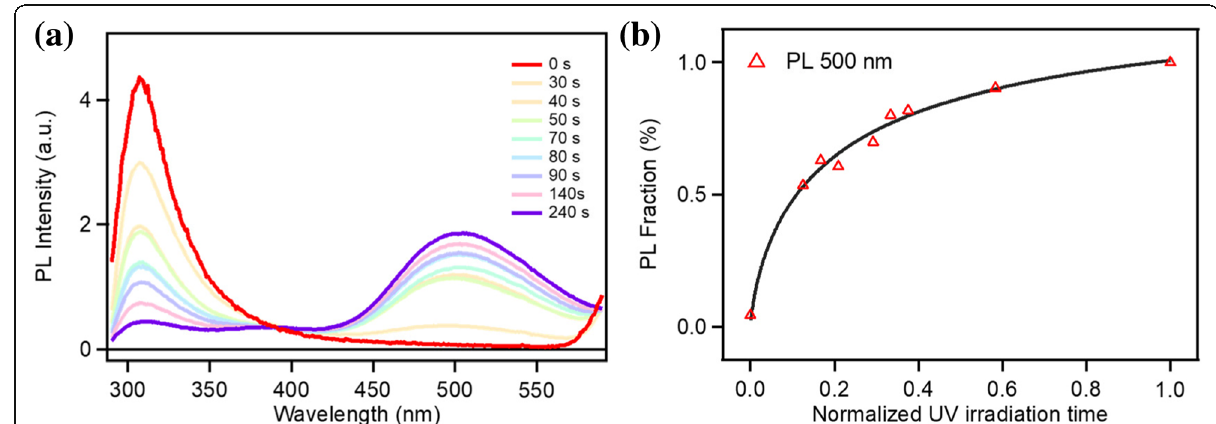
Fig. 5 Steady PL spectra of few layer nano-graphene with various UV exposure time excited at 270